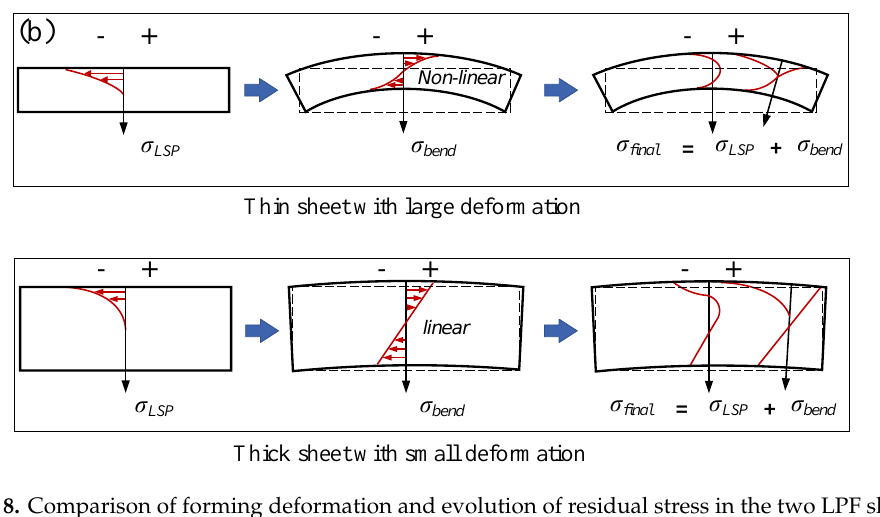
Figure 8. Comparison of forming deformation and evolution of residual stress in the two LPF sheets: ( a ) measured global deformation of the two LPF sheets and ( b ) effect of deformation compatibility on residual stress distribution.